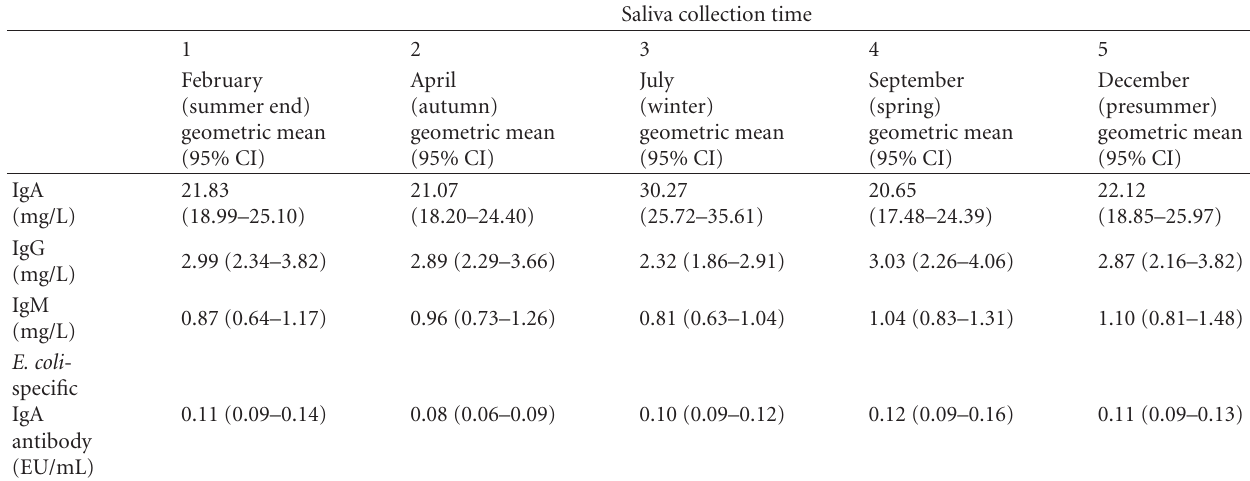
Table 2: Salivary immunological parameters, reported as geometric mean and 95% confidence interval (CI), at each assessment point during the pre-school